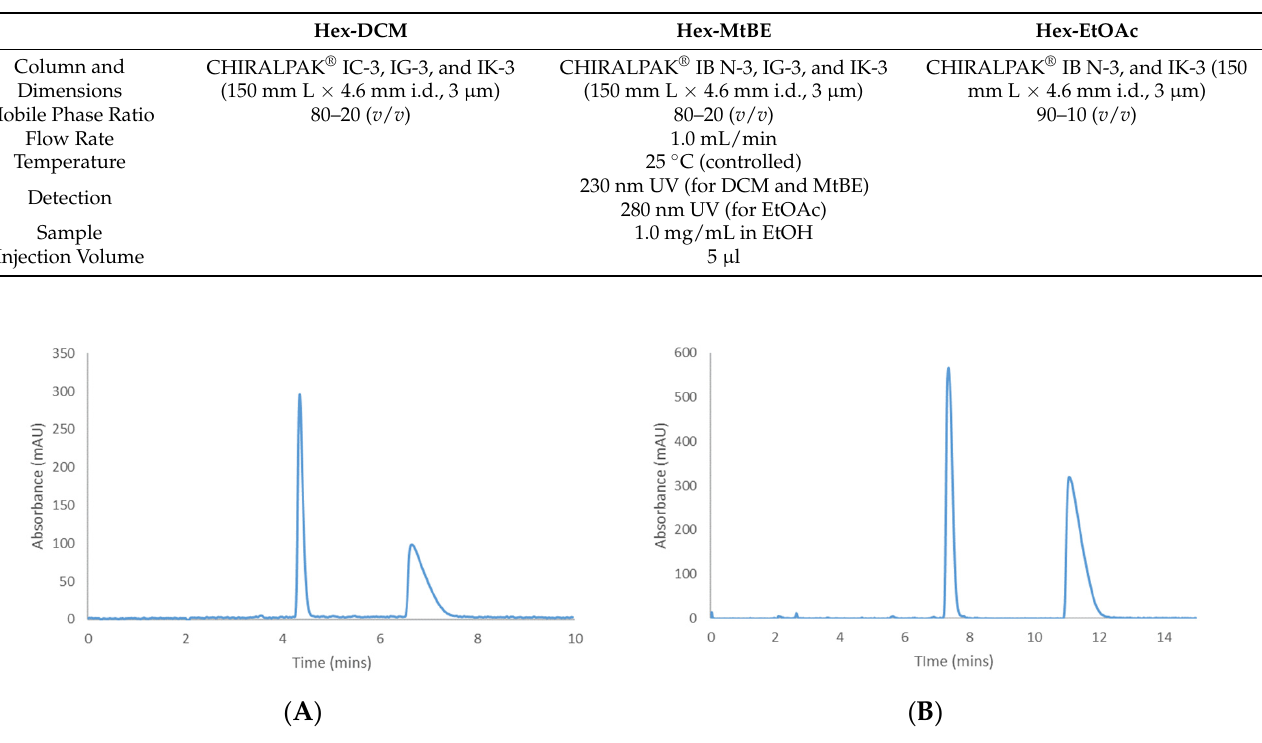
Figure 3. Separation of cannabichromene ( A ) and cannabicyclol ( B ) on CHIRALPAK ® IK-3 with Hex − DCM = 80 − 20 ( v / v ).